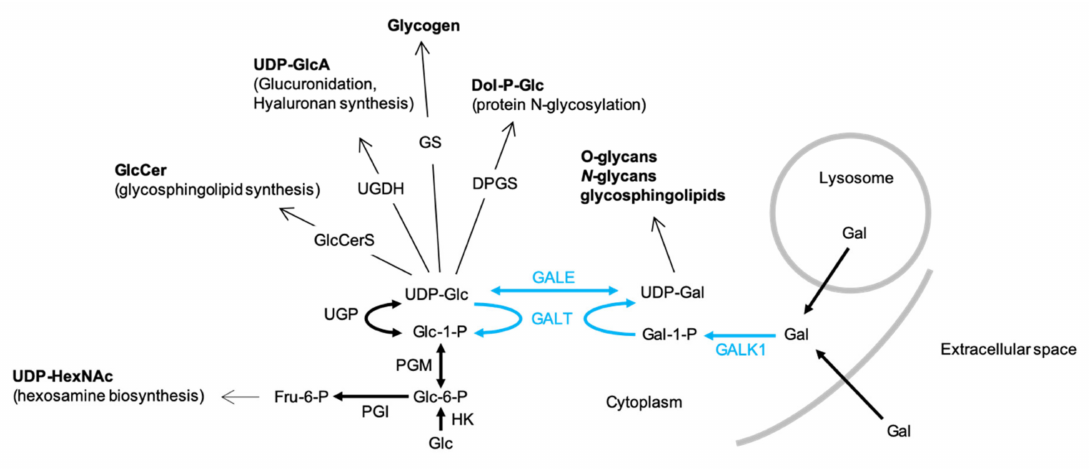
Figure 1. The biosynthesis and physiological roles of UDP-glucose (UDP-Glc) and UDP-Gal-UDP-Glc and UDP-Gal are utilized in many biosynthetic pathways: GlcCerS, glucosylceramide synthase; UGDH, UDP-glucose dehydrogenase; GS, glycogen synthase; DPGS, dolichol-P-glucose synthase. UDP-Glc is generated from either UDP-Gal by UDP-galactose 4-epimerase (GALE) or from glucose-1-phosphate (Glc1P) and UTP by UDP-Glc pyrophosphorylase (UGP). The synthesis of UDP-Gal via the Leloir pathway (blue arrows) itself requires UDP-Glc. After transport into the cell, galactose (Gal) is phosphorylated by galactokinase (GALK1) to yield galactose-1-phosphate (Gal1P), which in turn is converted into UDP-Gal by galactose-1-phosphate uridyltransferase (GALT), whose uridyl donor is UDP-Glc. UGP deficiency could potentially provoke increased fluxing of Glc-6-P through the hexosamine biosynthesis pathway to yield increases in cellular UDP-GlcNAc / UDP-GalNAc (UDP-HexNAc). The bold arrows represent single reaction steps whereas normal arrows indicate pathways involving several